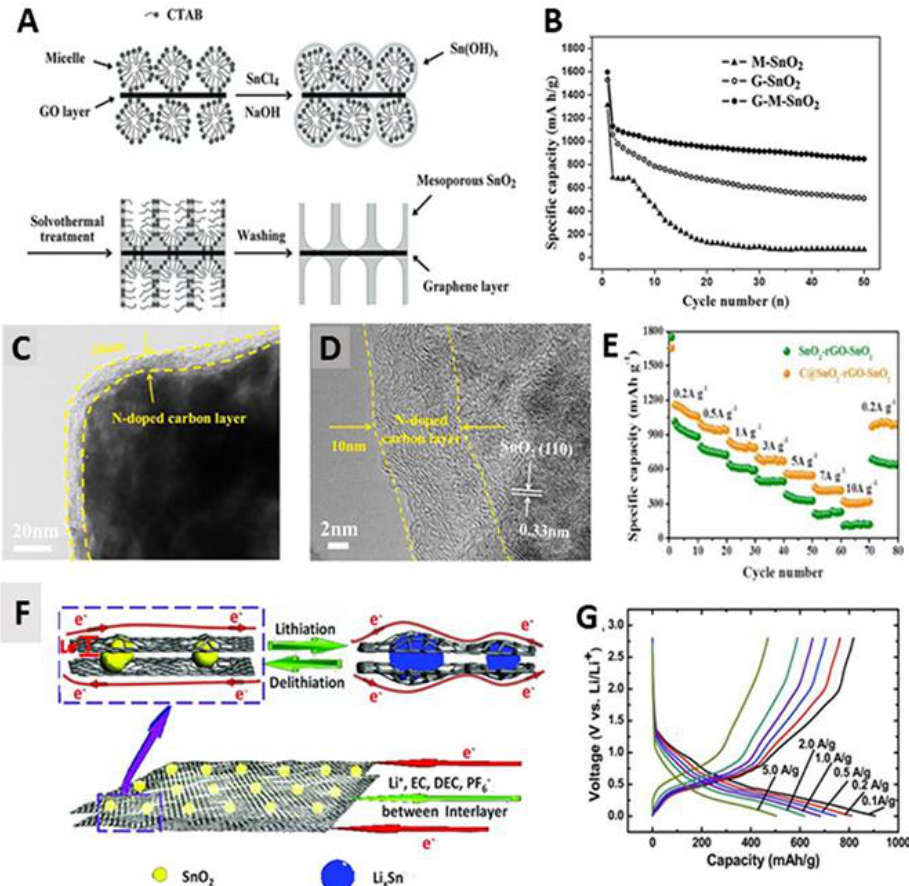
Figure 12. ( A ) Schematic mechanism for the formation of mSnO 2 /G. ( B ) The discharge capacities as a function of cycle numbers for the three samples at 0.1 C. ( A , B ) Reprinted with permission from Ref. [67], Copyright (2013) John Wiley & Sons. ( C ) TEM ( D ) HRTEM images of carbon-coated mSnO 2 /G/mSnO 2 . ( E ) Rate performance of carbon-coated mSnO 2 /G/mSnO 2 . ( C – E ) Reprinted with permission from Ref. [76], Copyright (2019) Elsevier. ( F ) Schematic representation showing paths for Li ions and electrons in the ( G ) Charge/discharge curves of sandwich-like N-doped SnO 2 /G. ( F , G ) Reprinted with permission from Ref. [92], Copyright (2012) John Wiley and